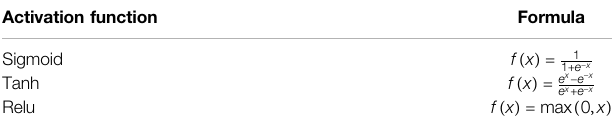
TABLE 1 | Expressions for the activation